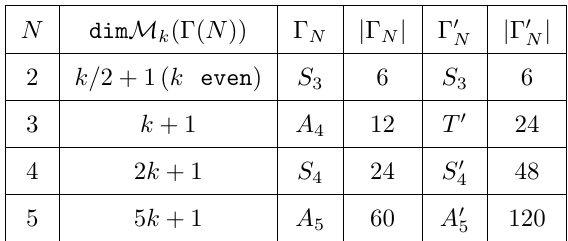
Table 1 . The dimension formula dim M k ((cid:0)( N )) for 2 (cid:20) N (cid:20) 5, and the order of (cid:0) N and (cid:0) 0 Notice that (cid:0) 0 group ID of T 0 , S 0